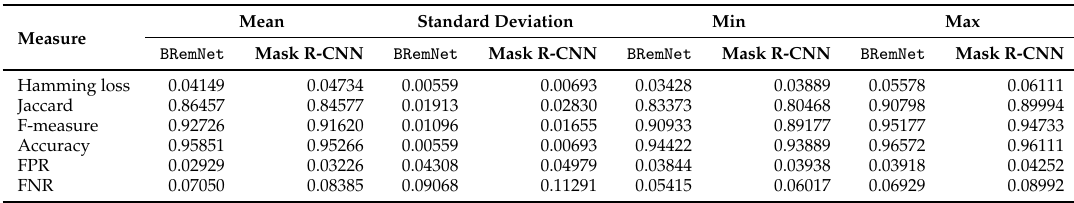
Table 1. Mask segmentation